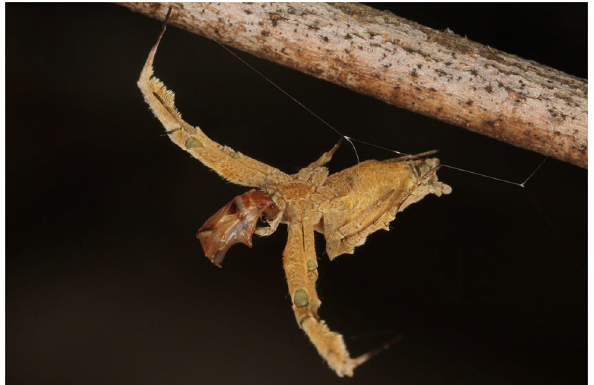
Figure 7. Female of Uloborus sp . feeding on a prey item captured in the field (picture from Marcelo de Oliveira final concentrations at the well plate are listed below (Table 1). At least, 5 different biological samples were used to each enzyme assay. Sodium dodecyl sulfate–polyacrylamide gel electrophoresis (SDS-PAGE). SDS-PAGE was per- formed with one individualized midgut homogenized in 500 μl of ultra-filtered cold water. The homogenate sample was submitted to VivaSpin 20 centrifugal concentrator MWCO 10 kDa using ultrafiltered water as dilu- ent was concentrated 500 μl of homogenate sample, which corresponds to, was resuspended in 20 μl of sample buffer (approximately, a total of 10 μg). Samples from Uloborus sp . midgut (approximately 10 μg of protein) were submitted to VivaSpin 20 centrifugal concentrator MWCO 10 kDa using ultrafiltered water as diluent. After that, samples were concentrated in vacuum centrifugation (speed vac), and resuspended (total of 10 μg of protein) in 20 μl of sample buffer, containing: 60 mM Tris–HCl buffer (pH 6.8), 2.5% SDS, 0.36 mM b-mercaptoethanol, 10% (v/v) glycerol, and 0.005% (w/v) bromophenol blue, thereafter, the sample was heated at 100 ºC for 5 min. Samples were applied onto a 12% polyacrylamide gel according to 75 . The electrophoresis was performed at 150 V, and the gel was silver stained 76 .